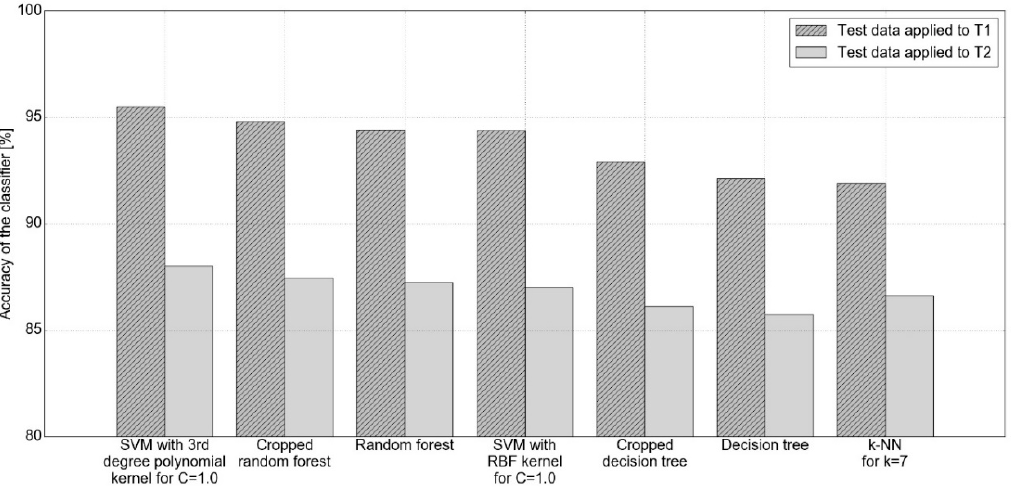
Figure 7. Comparison of the classifiers’ accuracy obtained for test scenarios T 1 and T 2 for the test data recorded for individuals who did not record the training data (T_12_set) and the SP training procedure (classifiers trained on the parameters of the IMU signals).